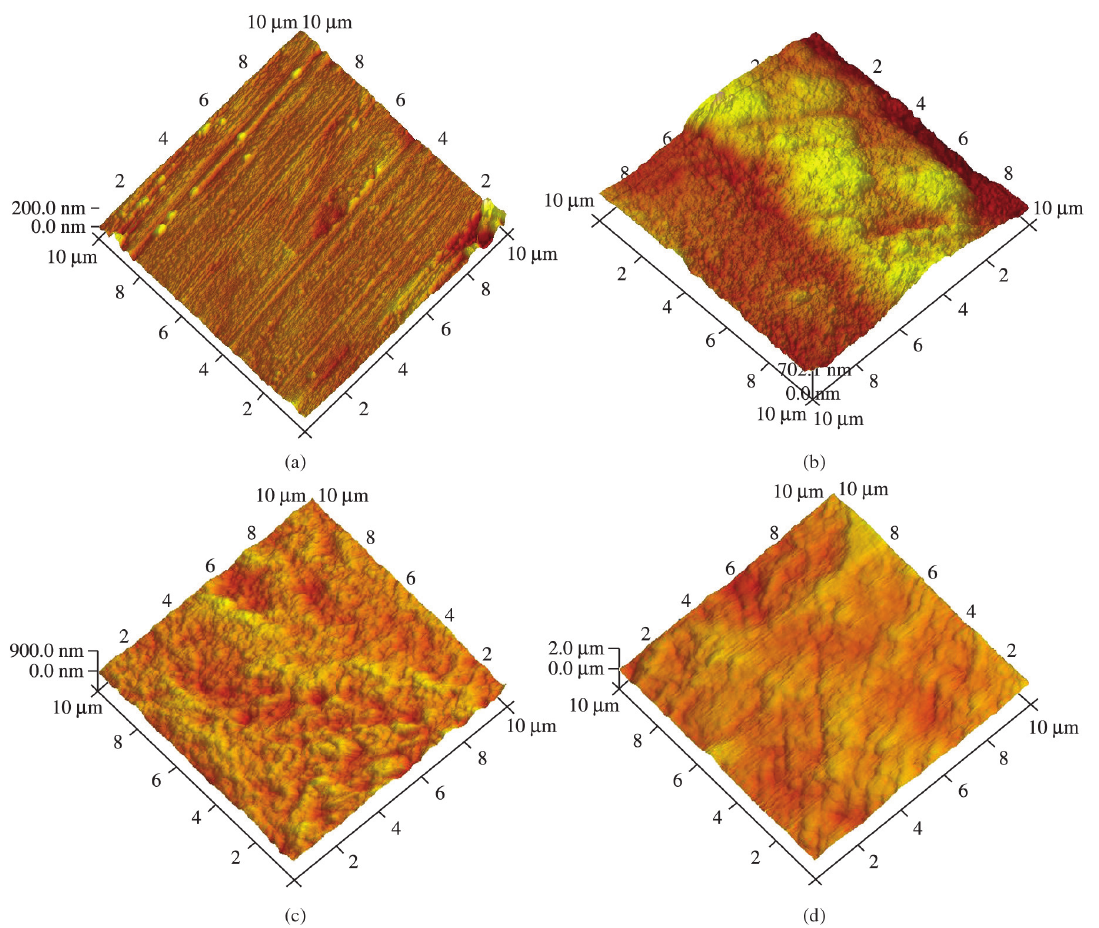
Figure 2. Surface morphology: (a) machined control; (b) acid etching and heat treatment; (c) acid etching and soaking in SBF for 7 days; (d) acid etching and soaking in SBF for 14